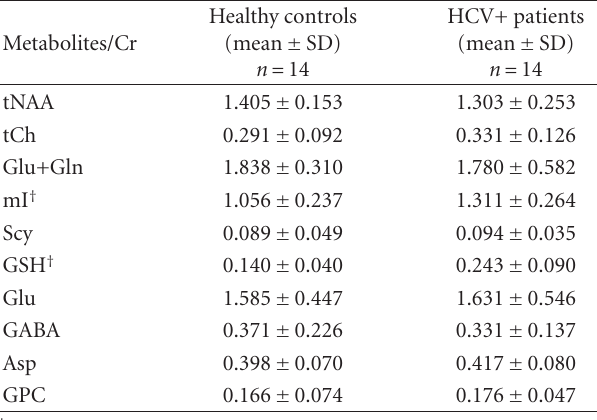
Figure 3: A representative 2D L-COSY spectrum of a 54 years old healthy control. Table 1: Metabolite changes between healthy controls and HCV+ patients calculated from the 2D L-COSY